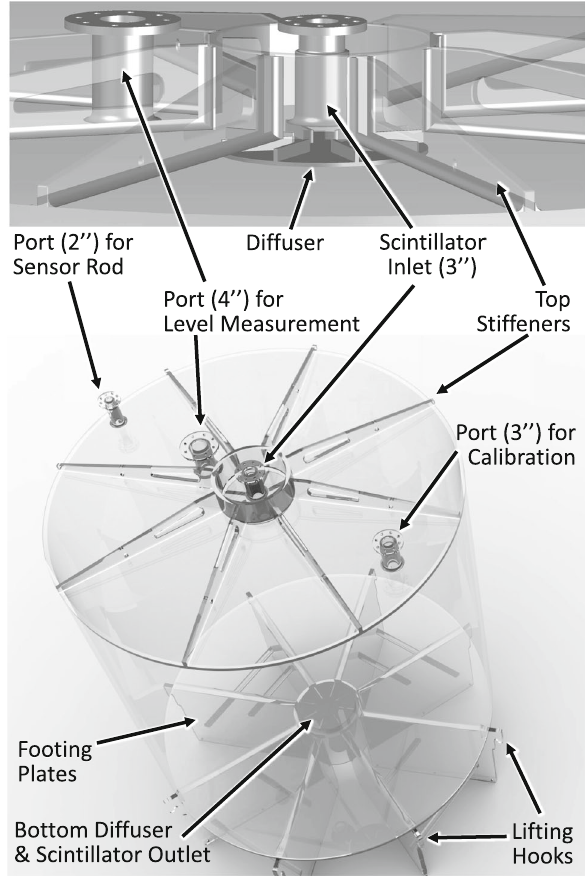
Fig. 4 The Acrylic Vessel of OSIRIS: the lower panel shows a general overview, the upper panel a detailed picture of the LS inlet